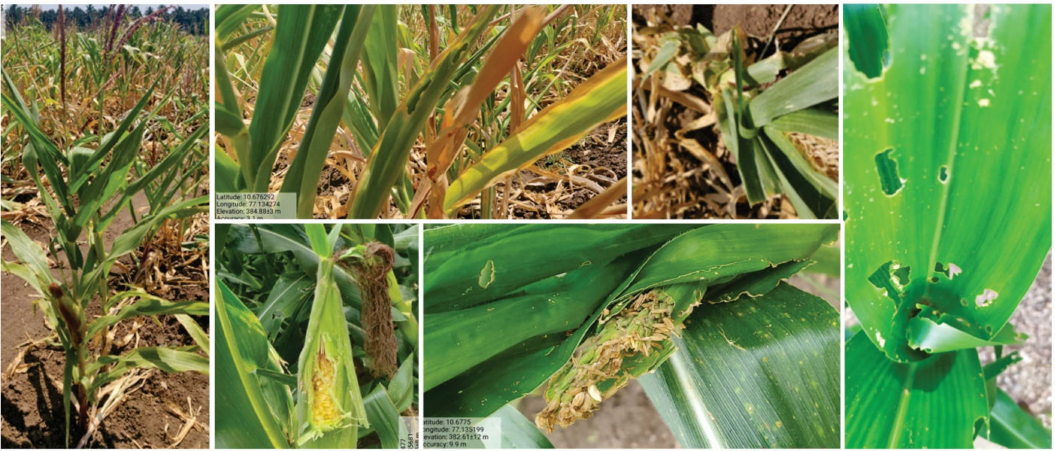
Figure 7. Photos taken in the pest infestation